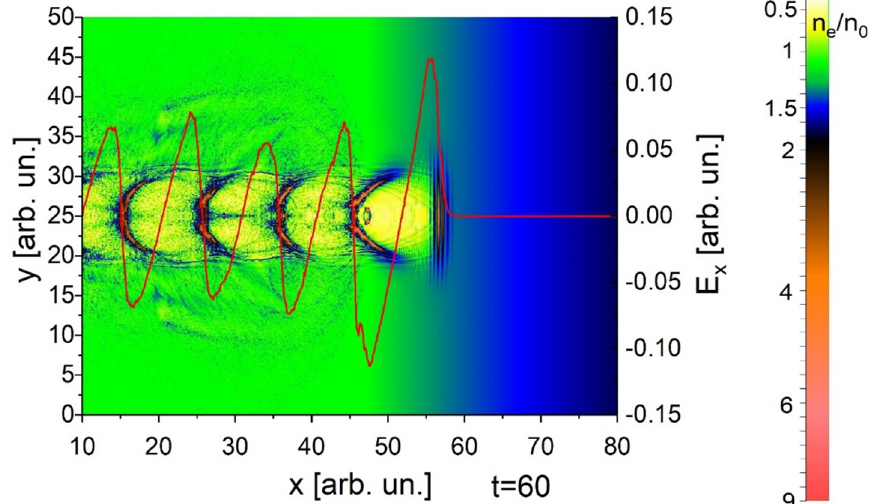
60 t T = . The self- 0